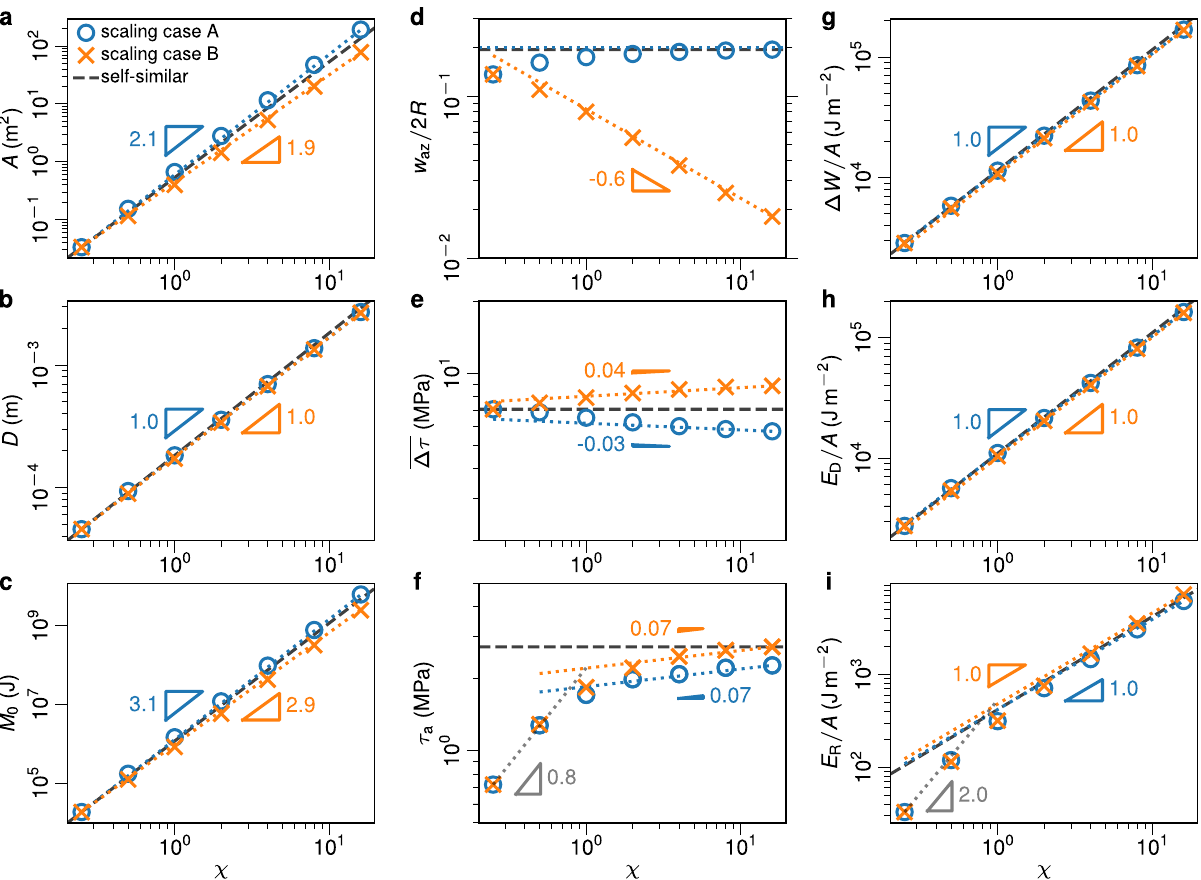
Fig. 2 Scaling of earthquake source parameters in both scaling cases. Triangles and the annotated numbers indicate the power of trend lines, i.e., p in V ∝ χ p for different parameters V . Black dash lines indicate ideal self-similar scaling relations. Scaling is shown for: a Earthquake rupture area A. b Average slip D. c Seismic moment M 0 . d Earthquake arrest zone width w az scaled by rupture diameter 2 R. e Averaged stress drop Δ τ . f Apparent stress τ a . g